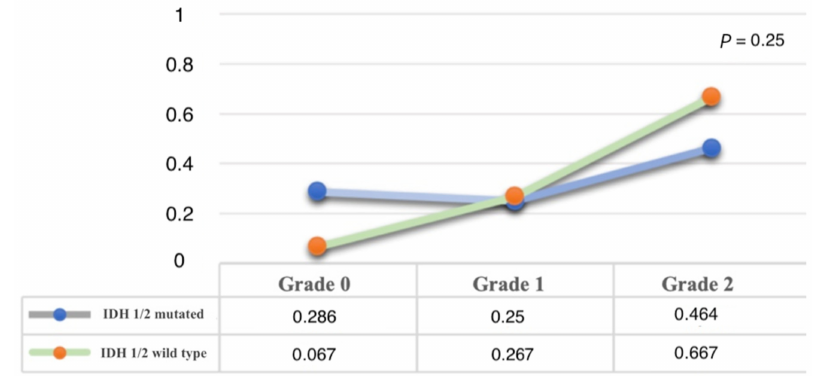
Figure 2. Correlation between IDH-1 status and fluorescence